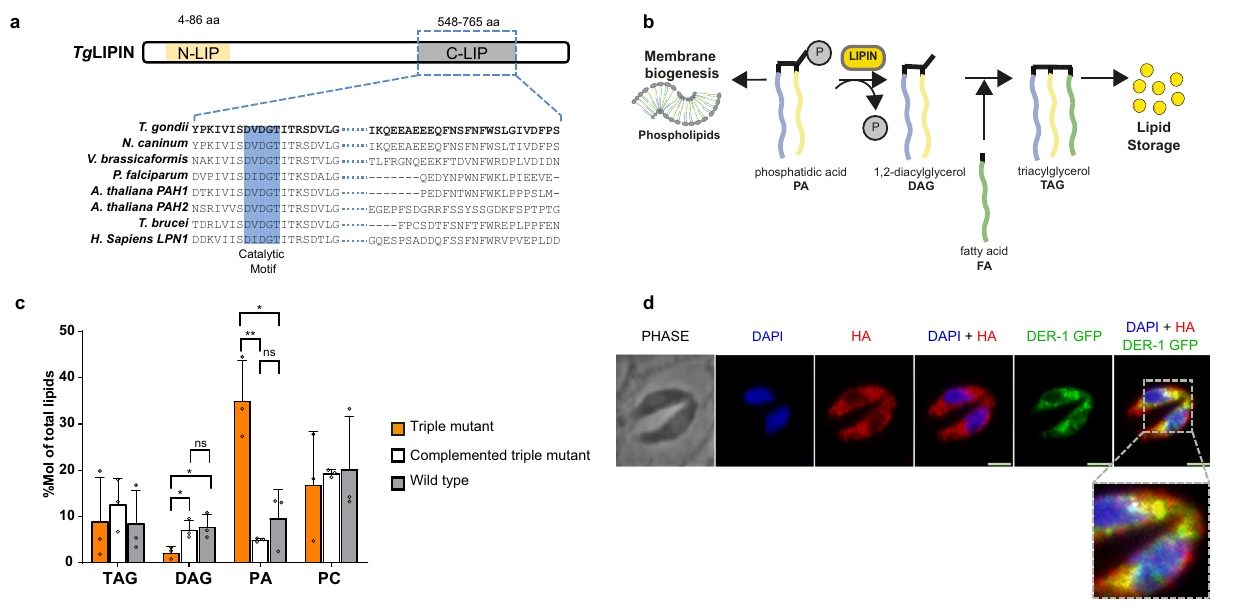
Fig. 1 T. gondii LIPIN ( Tg LIPIN) is a phosphatidate phosphatase localized to parasite cytoplasm and endoplasmic reticulum. a The C-LIP domain of Tg LIPIN is evolutionarily conserved among eukaryotic orthologs and harbors the catalytic motif DVDGT known to be central to PA phosphatase activity. b Graphical scheme of the biochemical function of LIPIN in the glycerolipid biosynthesis pathway in eukaryotes. c The complementation of the yeast triple KO mutant ( Δ dpp1 Δ lpp1 Δ pah1 ), lacking phosphatidic acid phosphatase activity, with the C-LIP domain of Tg LIPIN restores of PA and DAG ( n = 3, unpaired t test P values where * P = 0.024 DAG triple mutant vs DAG complemented triple mutant, * P = 0.032 DAG triple mutant vs DAG wild-type, ** P = 0.0039 PA triple mutant vs PA complemented triple mutant, * P = 0.039 PA triple mutant vs PA wild type). Data are presented as mean values + / − SEM. d IFA of Tg LIPIN-HA (endogenous C-terminal tag) with anti-HA, DAPI, and a transiently expressed DER-1-GFP plasmid shows co-localization of Tg LIPIN to the ER of the parasite. Scale bar: 2.0 μ